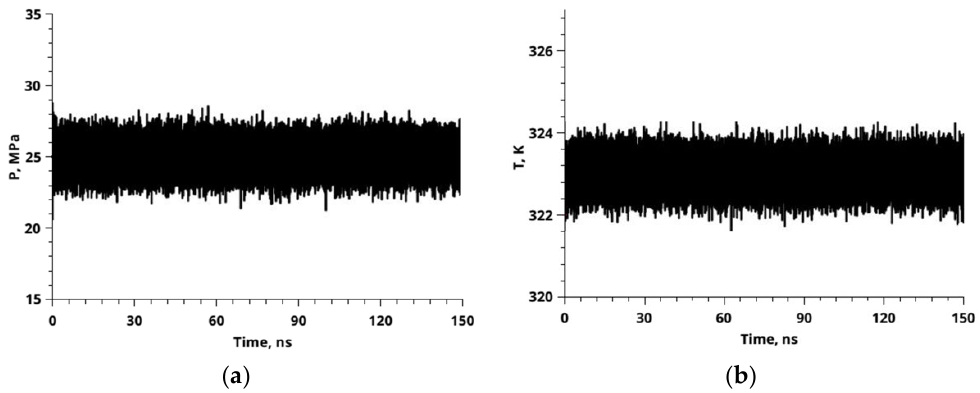
Figure 3. Time dependence of pressure ( a ) and temperature ( b ) during simulation process for 150 ns with a time step of 2 fs. These graphs confirm the reliability of the use of the barostat and thermostat and the absence of parameters of state (temperature in K and pressure MPa) changes throughout the duration of the simulation.